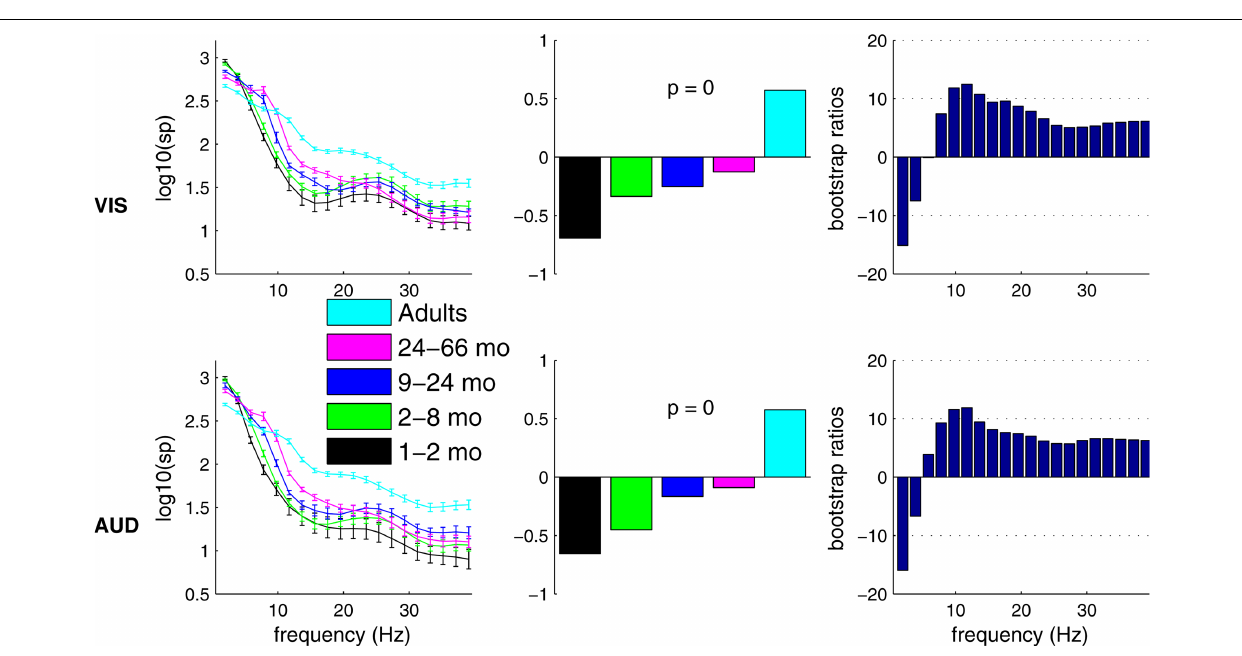
frequencies as shown in right panels. Results from both conditions replicate a known shift towards higher frequencies during maturation. Loss of stability around 6 Hz is likely due to an interaction between development-related increase in alpha rhythm frequency (Marshall et al., 2002) and the overall redistribution of power towards higher